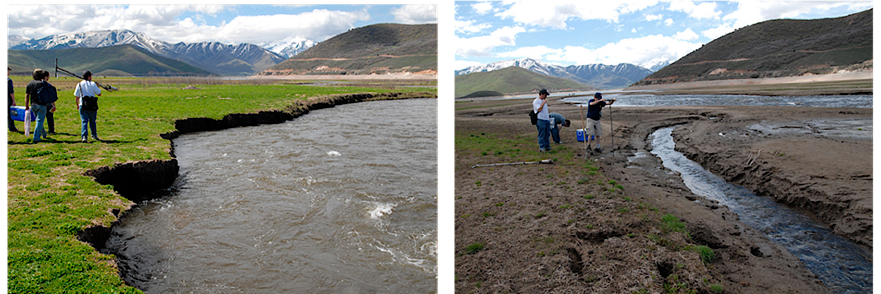
Figure 6. Typical sediment recutting channel geometry from the exposed DCR delta. The left panel shows an exposed channel with near vertical side slopes, the right panel shows an exposed channel with a gradual slope on the left, and a steeper but non-vertical slope on the right. Sonar data reveals similar submerged channel geometry.